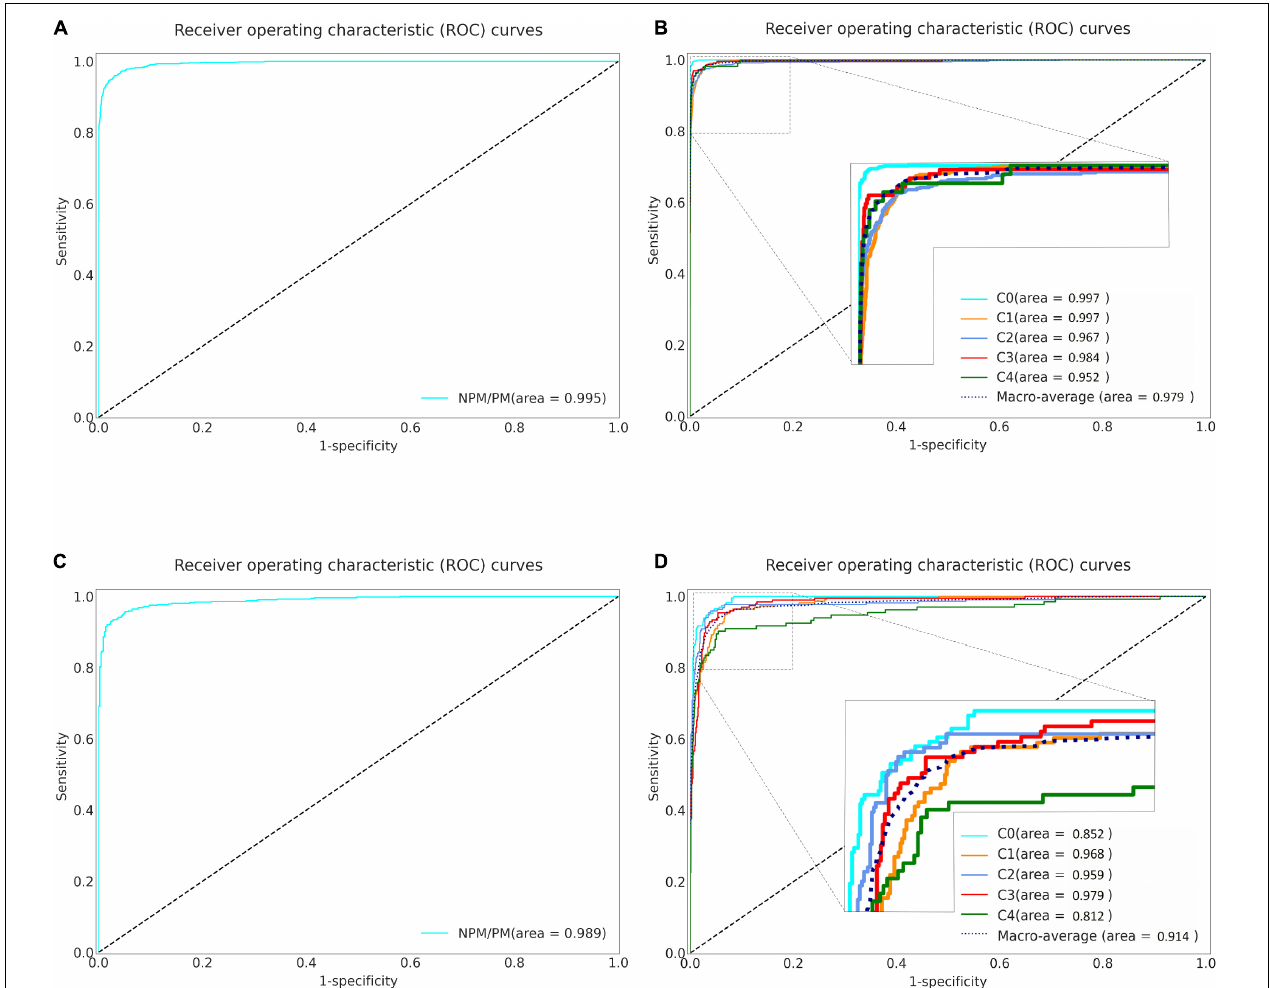
FIGURE 2 | Receiver operating characteristic (ROC) curves of Algorithm I and Algorithm II in five-fold cross-validation and external validation. (A) The ROC curve of the algorithm I for identifying pathologic myopia in five-fold cross-validation. (B) The ROC curve of the algorithm II for classifying the category of MM in five-fold cross-validation. (C) The ROC curve of the algorithm I for identifying pathologic myopia in external validation. (D) The ROC curve of the algorithm II for classifying the category of MM in external validation. NPM: non-pathologic myopia. PM: pathologic myopia. area: area under the receiver operating characteristic curve. C: